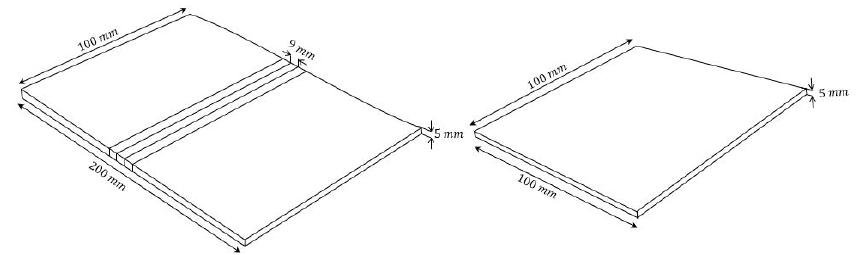
Figure 3. Pipe geometry model.